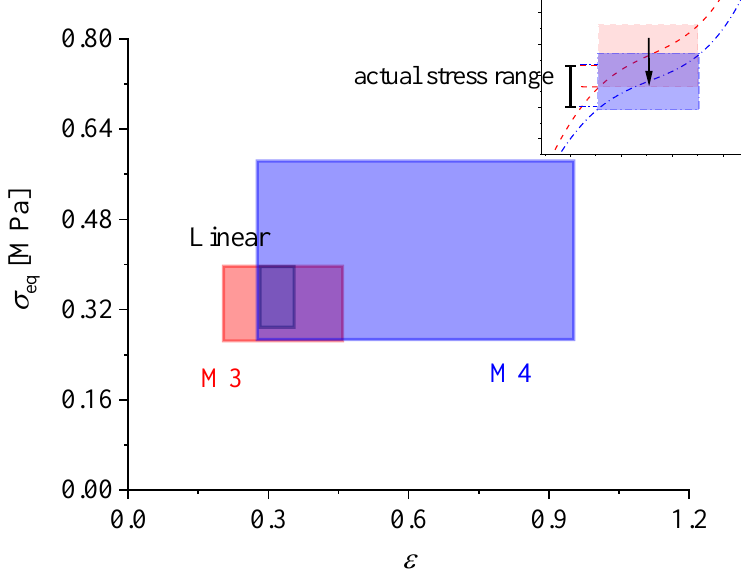
Figure 19. Effective stress range (ESR) of the fWEC. The rectangles represent the ESR of the WEC device during operation. The larger the rectangle is, the better the performance is for this material (which means a larger deformation can be achieved).